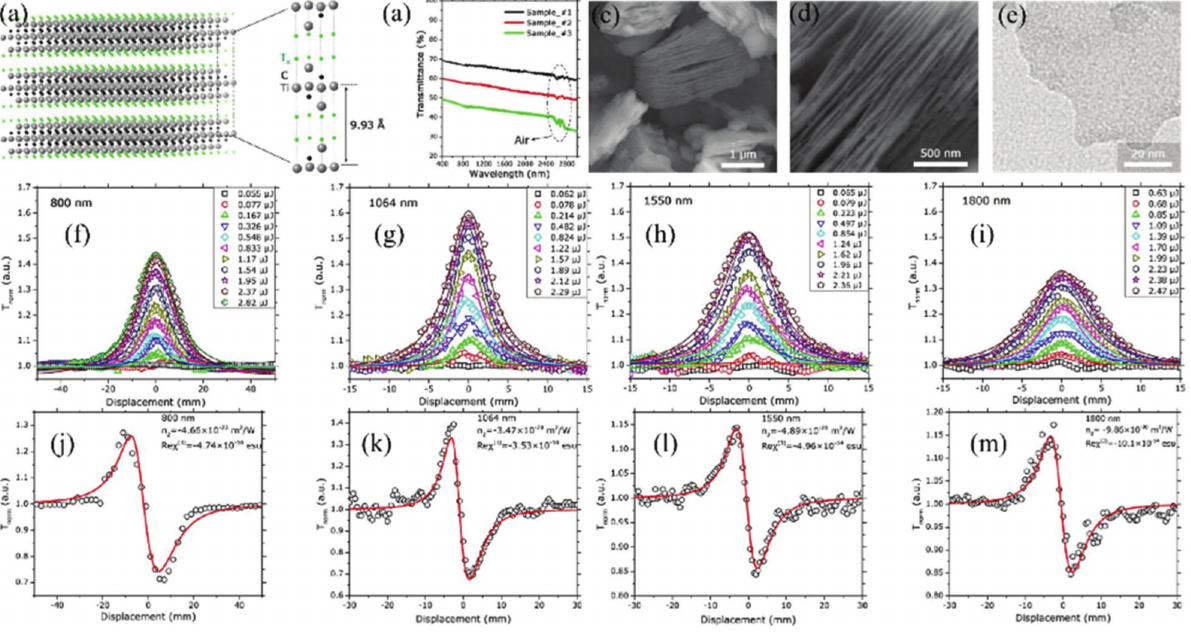
C T , (T = F, O, or OH)). 3 2 x C T . (B) Linear transmittance. (C) and (D) SEM images. (E) High-resolution TEM image. (E,F) Open 3 2 x C T at wavelengths 800, 1064, 1550, and 1800 nm. (J–M) Closed-aperture Z-scan 3 2 x C T at wavelengths 800, 1064, 1550, and 1800 nm. Reproduced with permission from Ref. [106]. Copyright 3 2 x